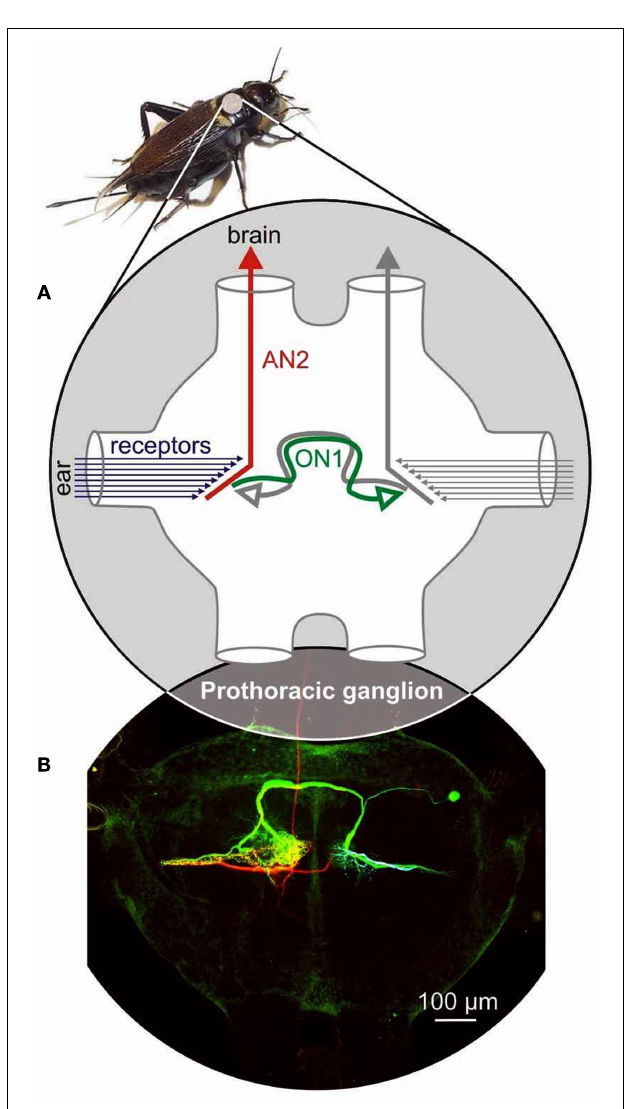
FIGURE 2 |Auditory neurons of the prothorax of crickets. (A) Auditory receptors project from the ears located on the tibiae of the forelegs to the prothoracic ganglion. A population of approximately 15 ultrasound receptors on each side provides inputs to the Ascending Neuron 2 (AN2) which carries the information to the brain, and to the Omega Neuron 1 (ON1), which inhibits the contralateral interneurons (both AN2 and ON1). (B) Morphologies of AN2 (red), ON1 (green), and an ultrasound receptor (blue) filled with fluorescent dyes. Note that while the AN2 and ON1 neurons were imaged together, the receptor has been superimposed post hoc